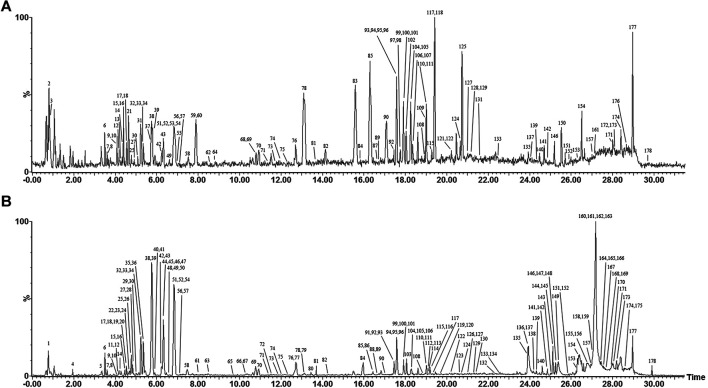
Representative base peak intensity (BPI) chromatograms of WFC in positive mode (A) and in negative mode (B) and total ions chromatogram (TIC) in positive mode (C) and in negative mode (D) by UHPLC-ESI-Q-TOF/MS.